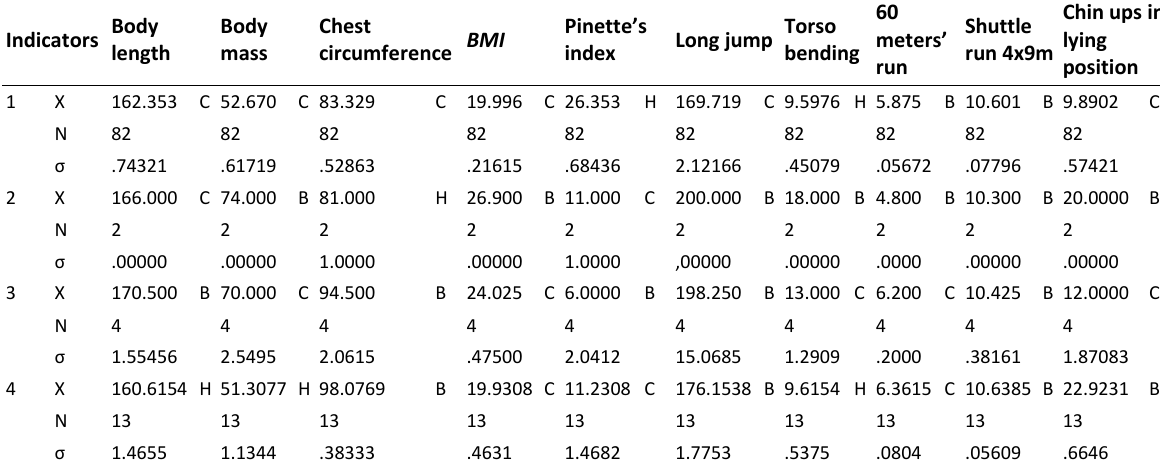
Table 2. Results of cluster analysis (girls) Body Body Indicators length